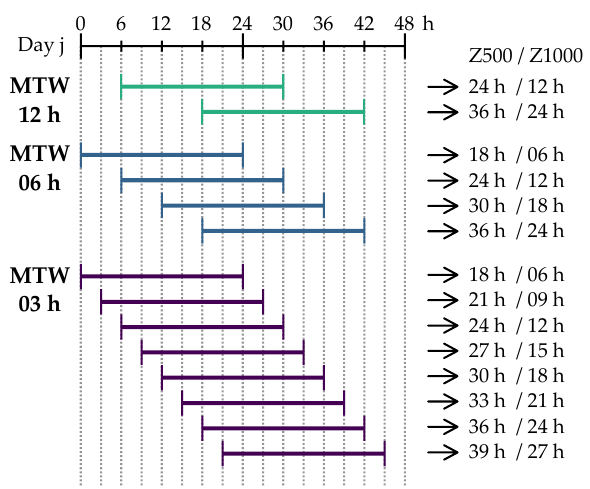
Figure 2. Illustration of the principle of a moving time window (MTW). The target situation is the same for the conventional ap- proach and the MTW, although the candidate situations with the MTW are 2, 4, or 8 times as many. The horizontal bars represent the 24h precipitation totals; their associated predictors are listed on the right-hand